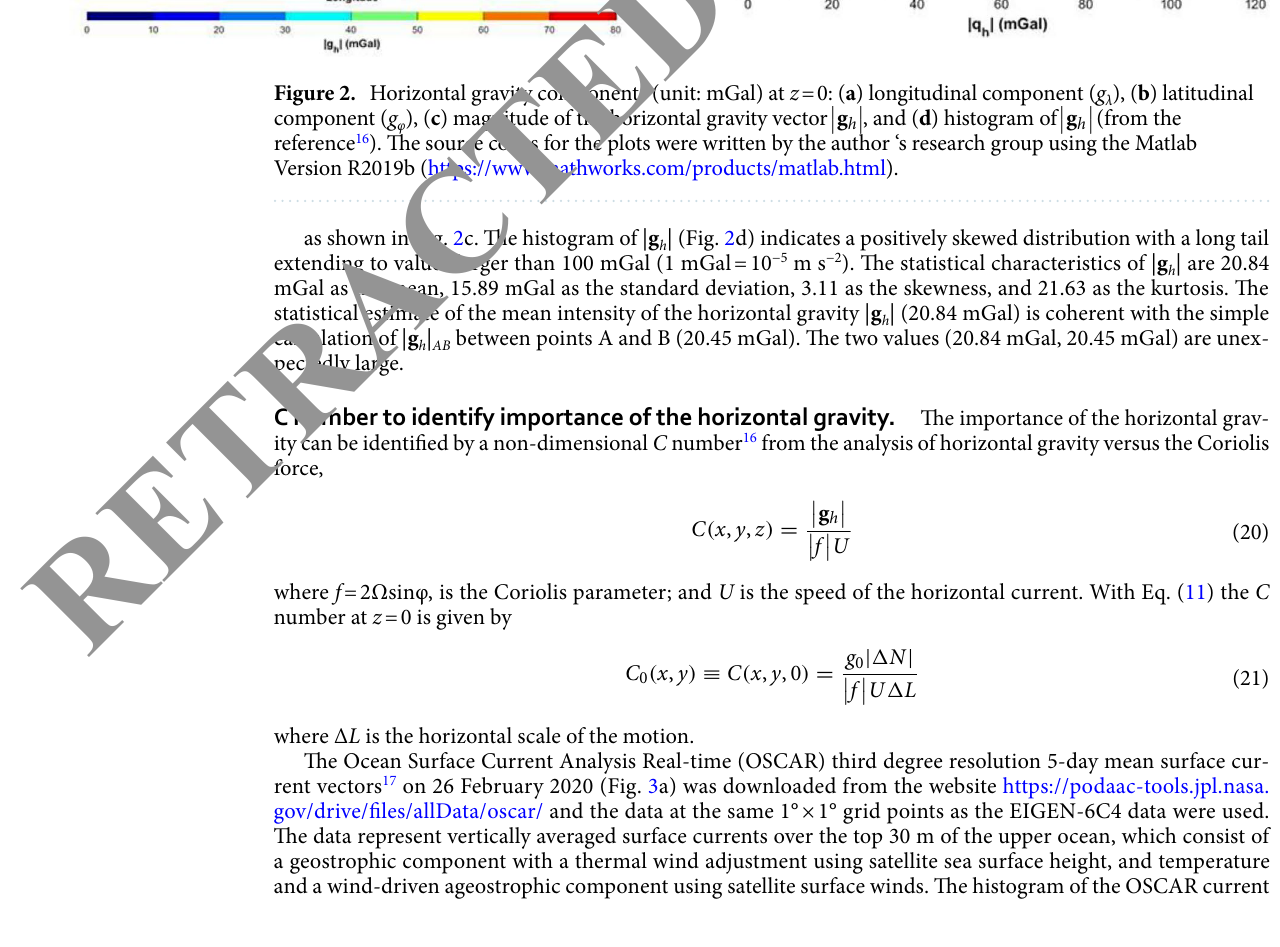
g h g h , and ( d ) histogram of (from the (cid:31) (cid:31) (cid:31) (cid:31) (cid:31) (cid:31) (cid:31) (cid:31)